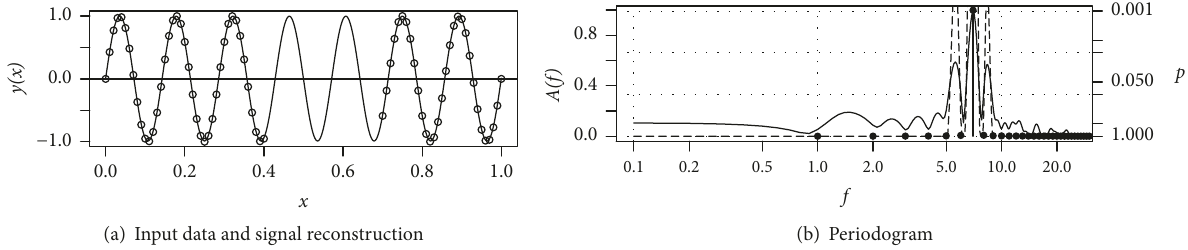
Figure 16: Simple Lomb-Scargle periodogram. The open symbols in panel (a) display the input signal. The solid line shows the reconstruction out of the spectrum. Panel (b) focuses on the periodogram. Here, the solid line corresponds to the spectral amplitude and the black points indicate the results of a DFT, as if there was no gap in the data. The dashed line represents the false alarm probability 𝑝 . Note the value of 1 is located at the bottom, whereas smaller values are displayed above.